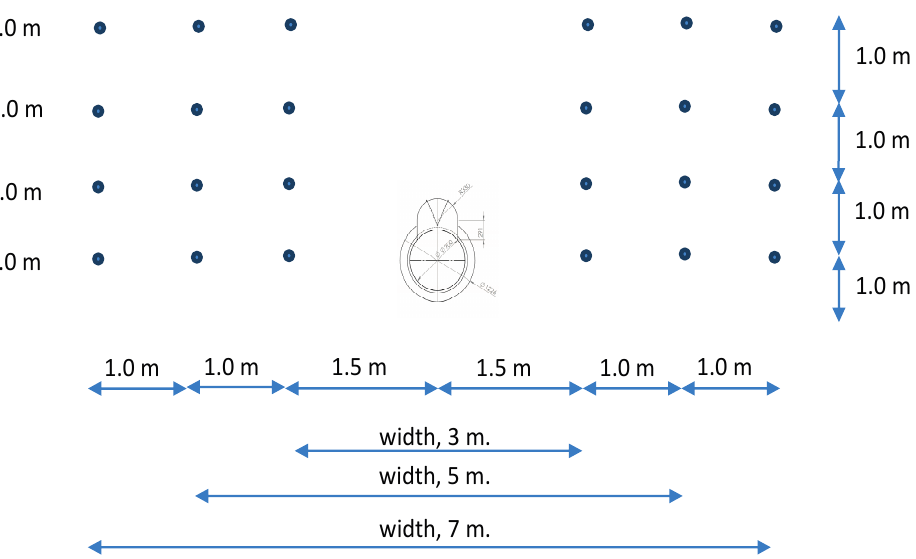
Figure 4. Air velocity measurement points for each section of the